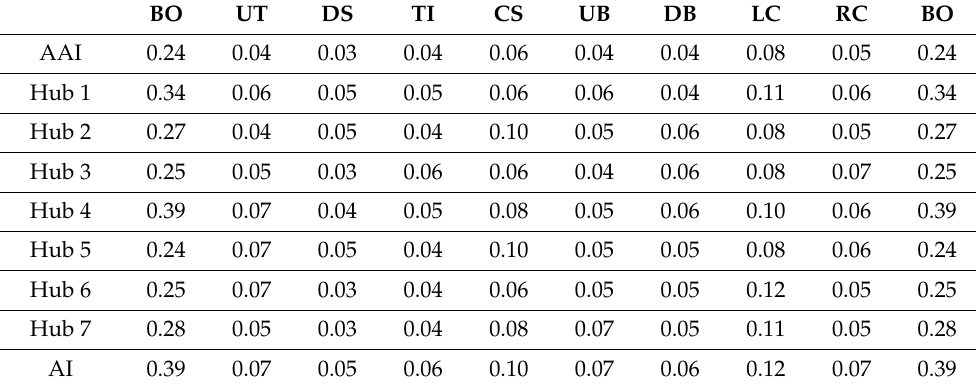
Table 11. Weighted